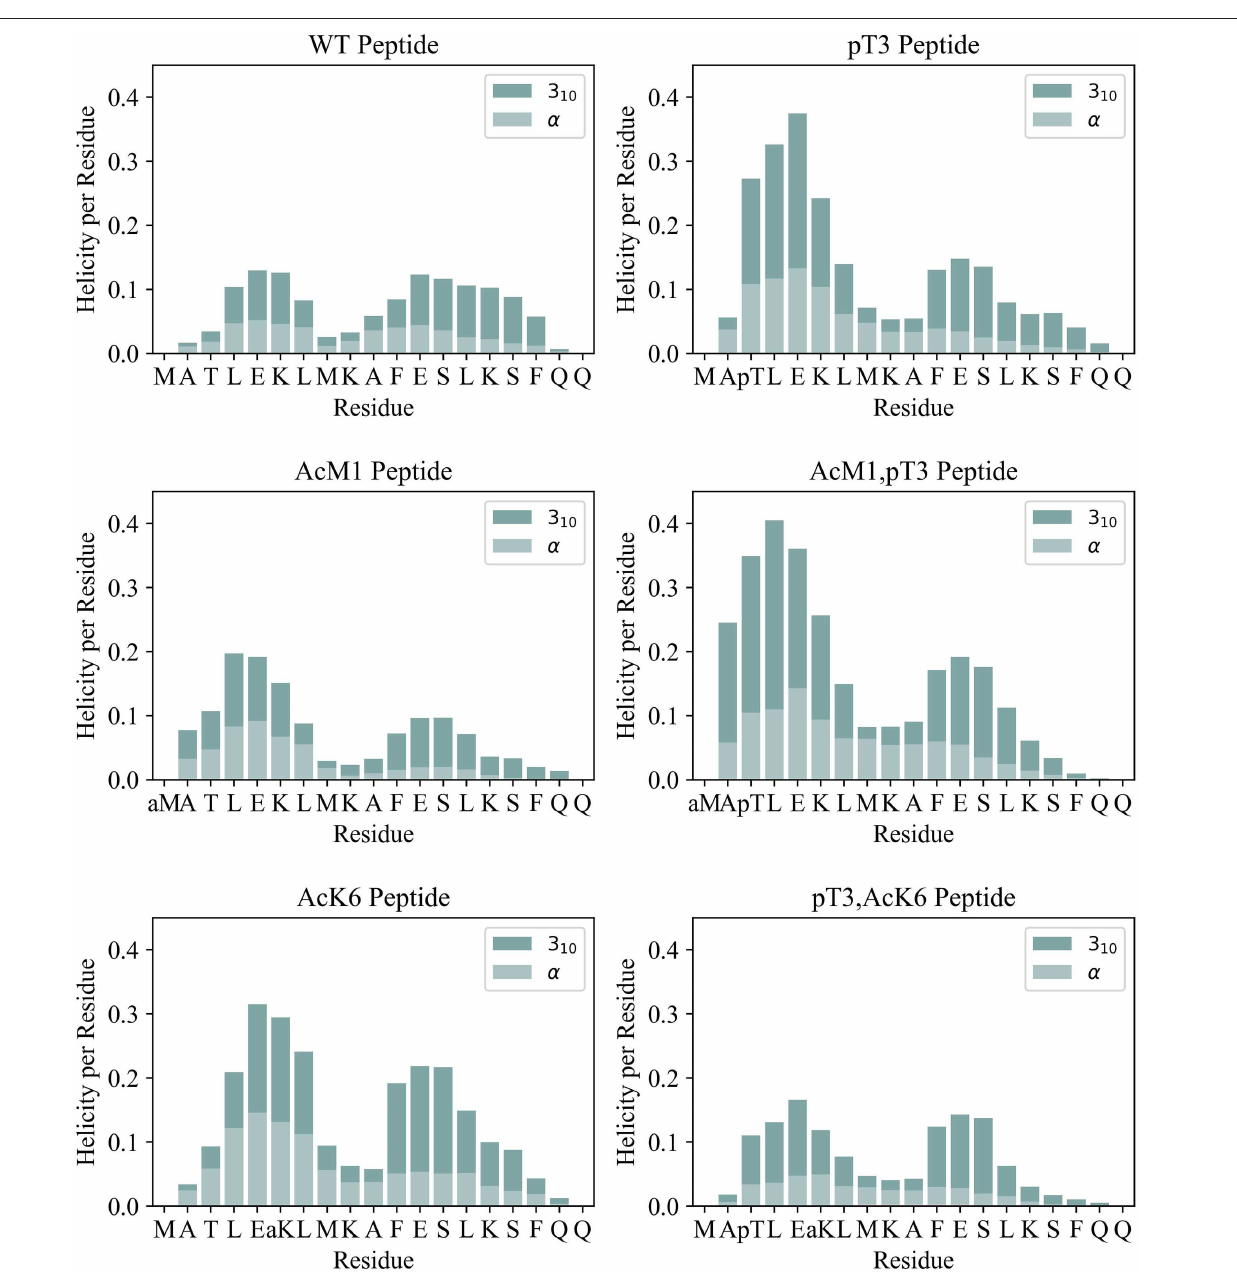
FIGURE 2 | Helicity per residue for the simulated peptides is shown as a stacked bar plot. The helix percentage (divided into α and 3 10 helix) was evaluated according to DSSP.